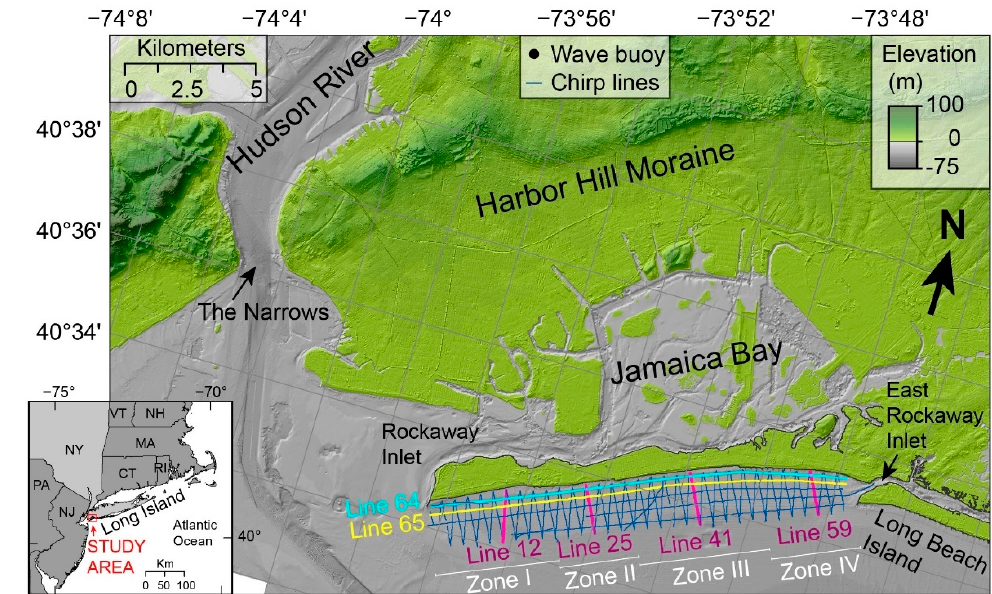
Figure 1. Location of the Rockaway, New York study area is indicated by the red rectangle in the bottom left inset. The geophysical survey spans the area from the nearshore to approximately two kilometers offshore of the Rockaway Peninsula. Chirp profiles acquired over the entire survey are shown in dark blue. In pink are dip lines shown in Figure 8, and strike lines highlighted in yellow and cyan are shown in Figures 9 and 10. The extents of geomorphic zones are indicated by the white lines on the barrier peninsula.